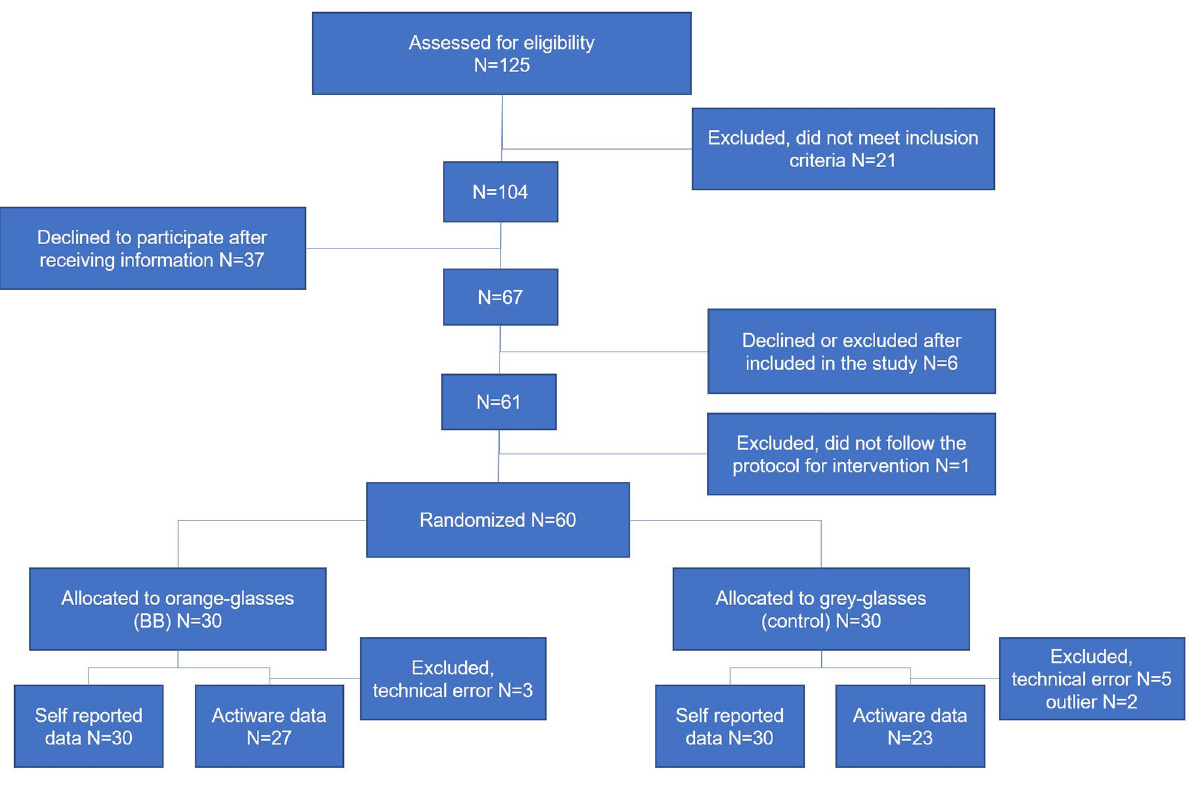
Fig 1. Flowchart of enrollment of pregnant women in the